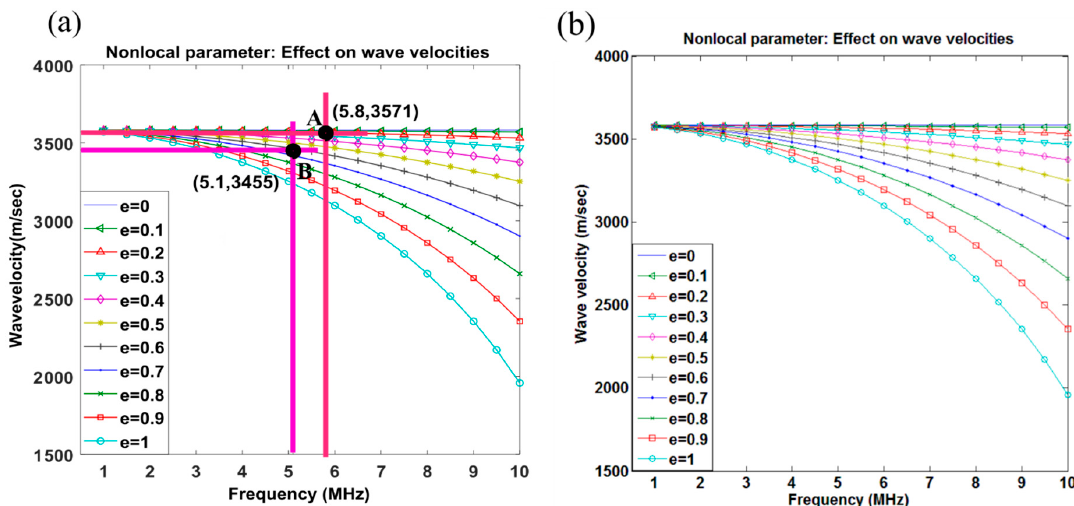
Figure 11. The Dispersion relationship of quasi-slow transversal wave mode resulting from intrinsic length scale effects ( ε ls = 0 to 1) ( a ) with piezo stiffening and ( b ) without piezo stiffening at frequency 1 MHz–10 MHz.